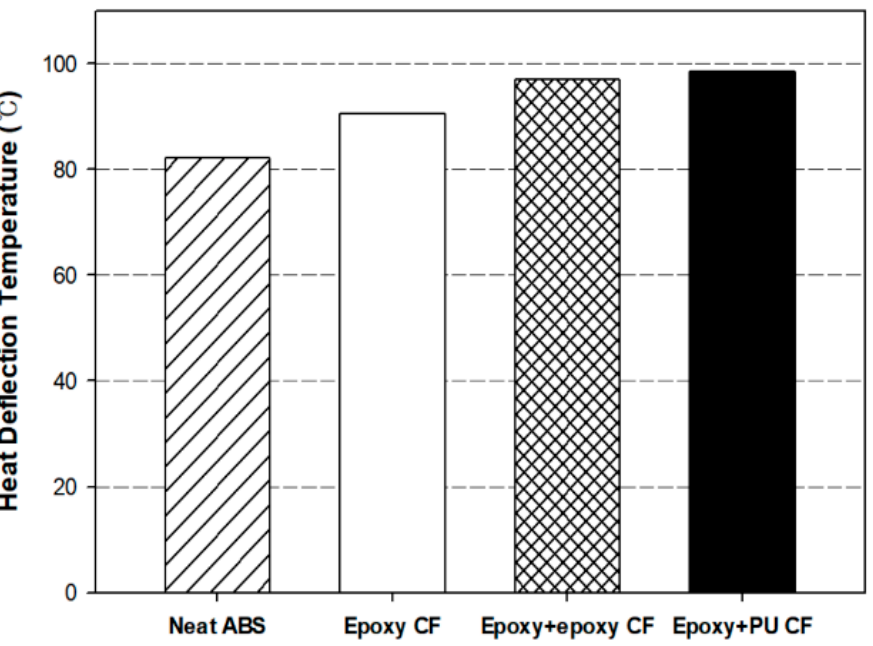
Figure 6. Heat deflection temperatures of neat ABS and carbon fiber/ABS composites with (epoxy) single-sized and (epoxy + epoxy, epoxy + PU) dual-sized carbon fibers.